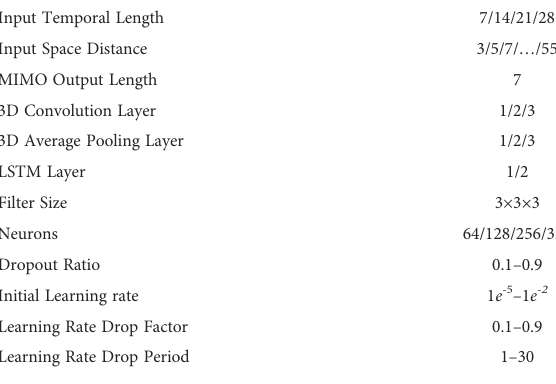
TABLE 2 The random research range of the hyperparameters.